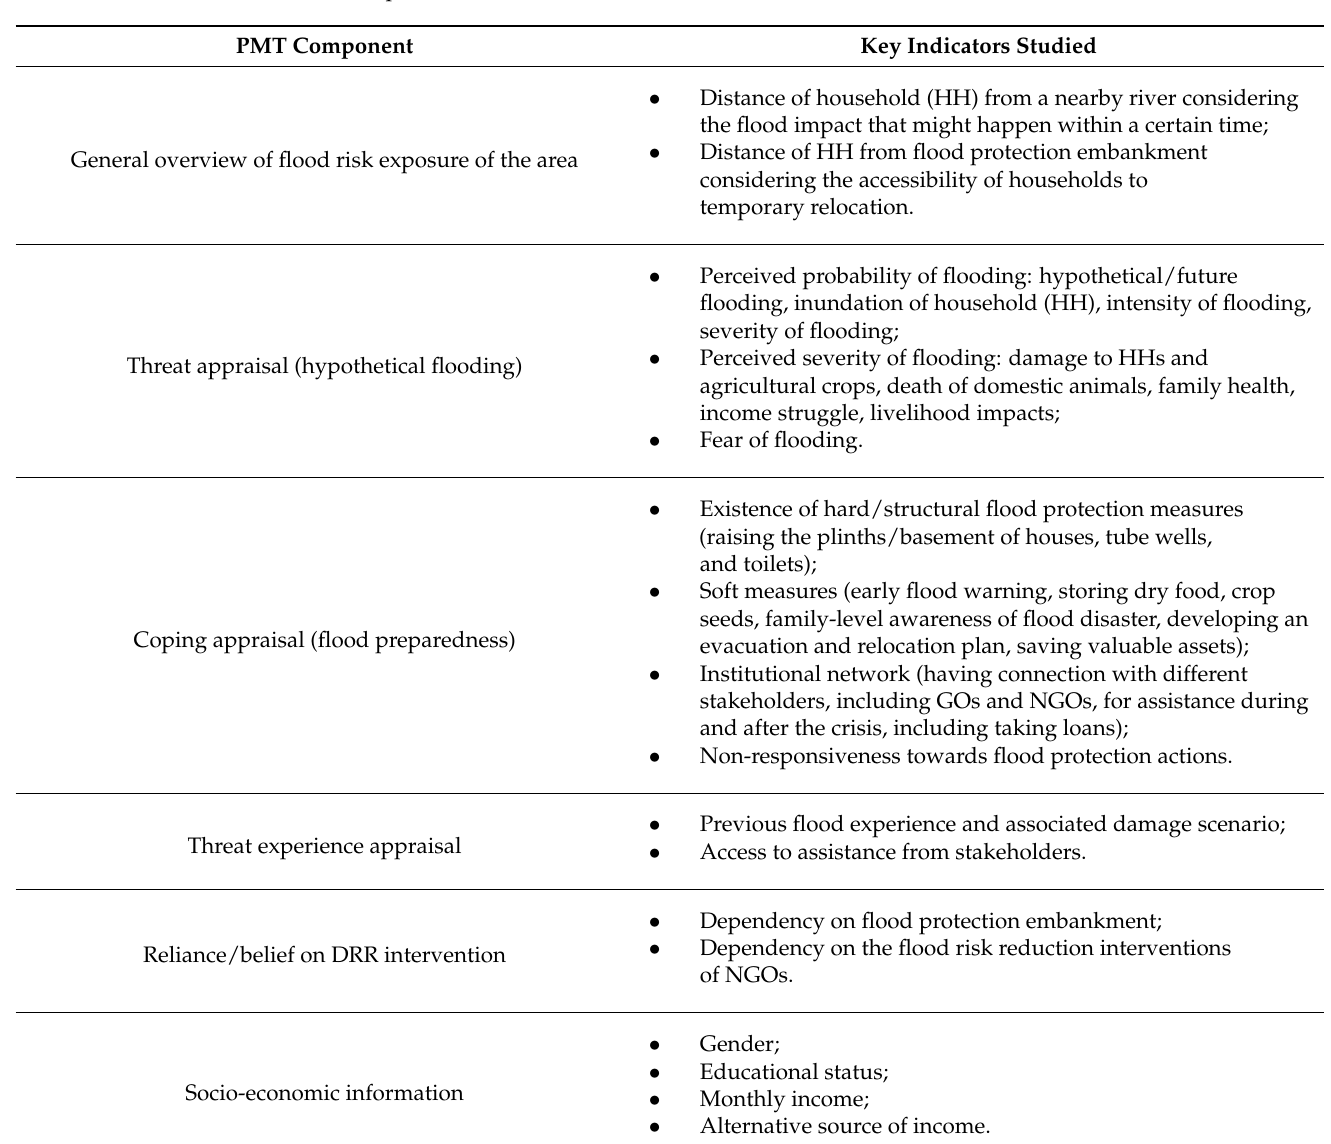
Table 1. Indicators associated with key PMT components that are studied in this research study (adopted from